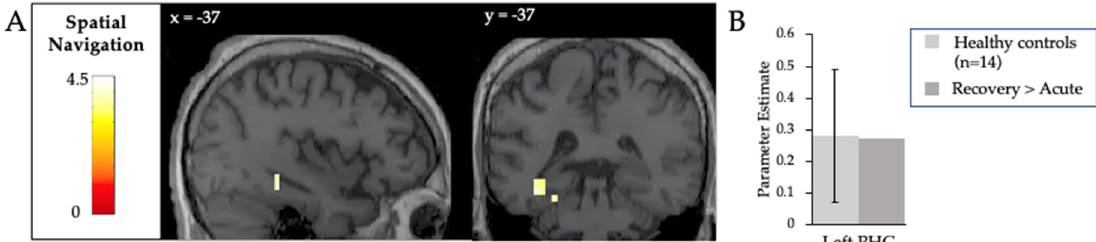
Figure 5. ( A ) Neural responses to the spatial navigation paradigm when comparing the activity of the recovery to the acute scan. Individual patient results are thresholded at p < 0.001. Images are masked inclusively by the group analysis of healthy control participants. ( B ) The difference in activity in the left parahippocampal gyrus is plotted adjacent to the mean activity observed in this region in 14 healthy participants performing the same task [20]. The error bars indicate the standard deviation of the healthy controls.